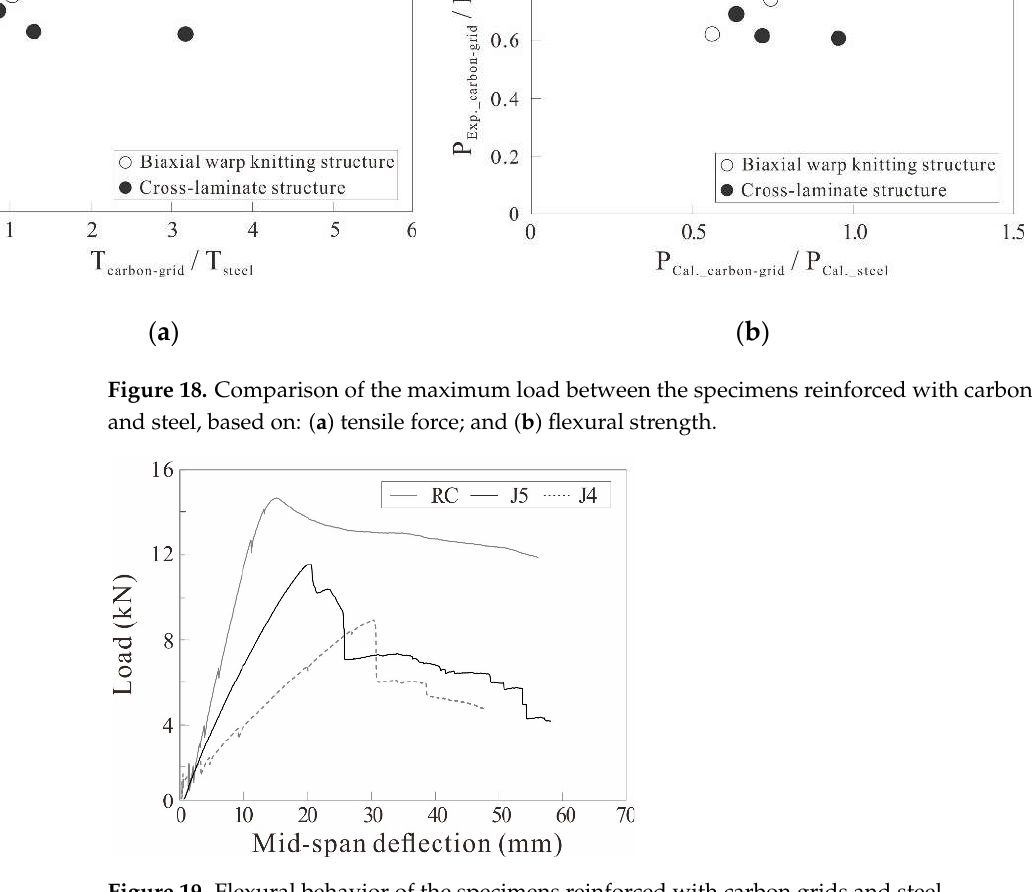
Figure 19. Flexural behavior of the specimens reinforced with carbon grids and steel.